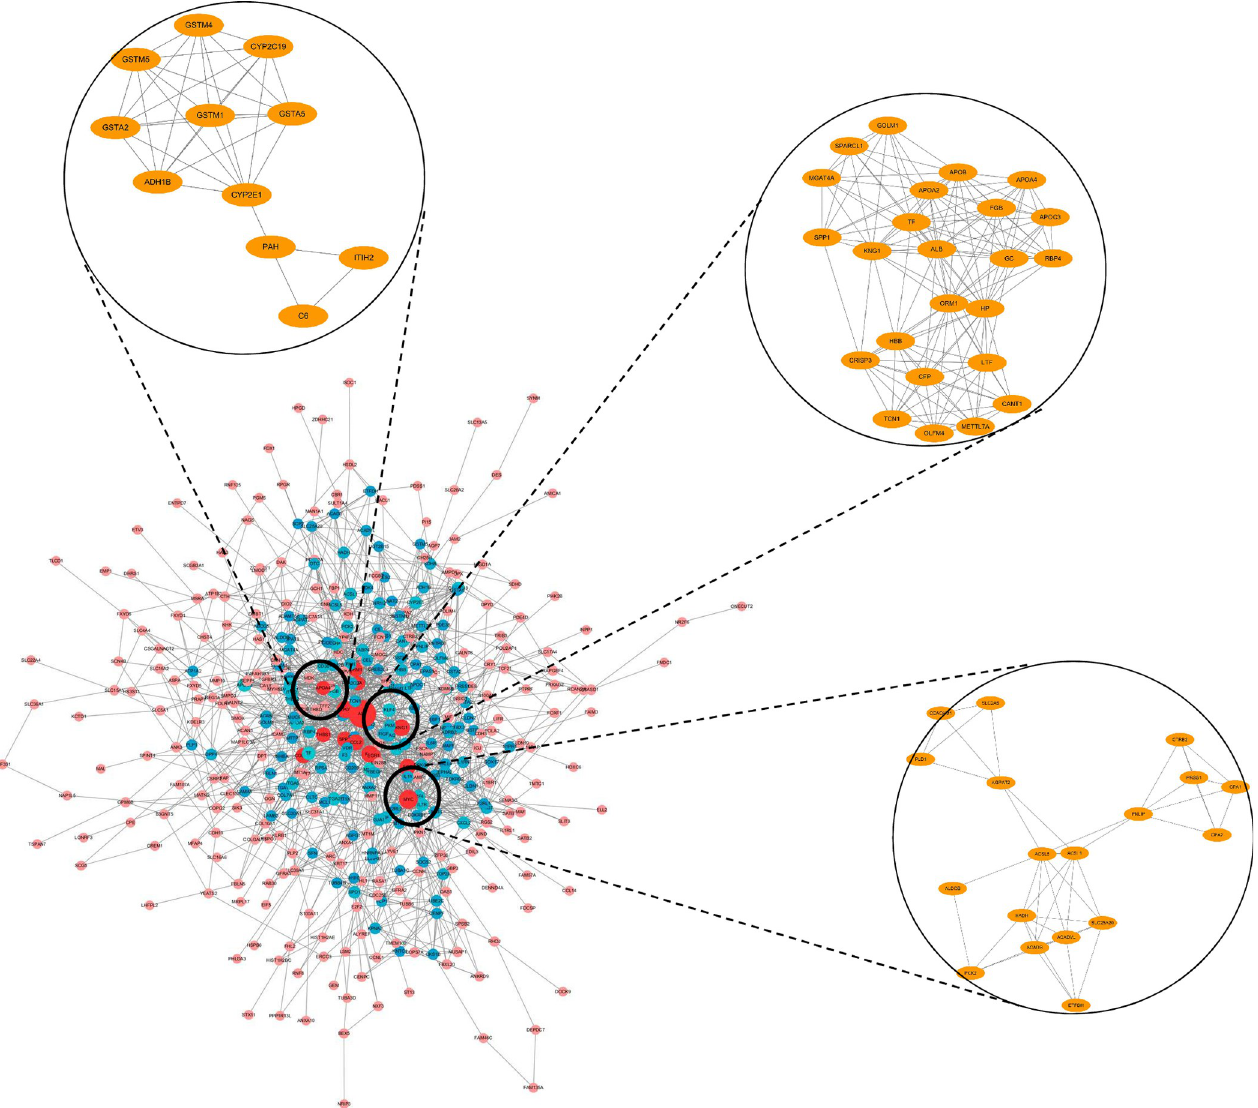
Fig 3. Top three modules from the protein-protein interaction network. The degrees of nodes were labeled in different colors, the red color means bigger degrees.